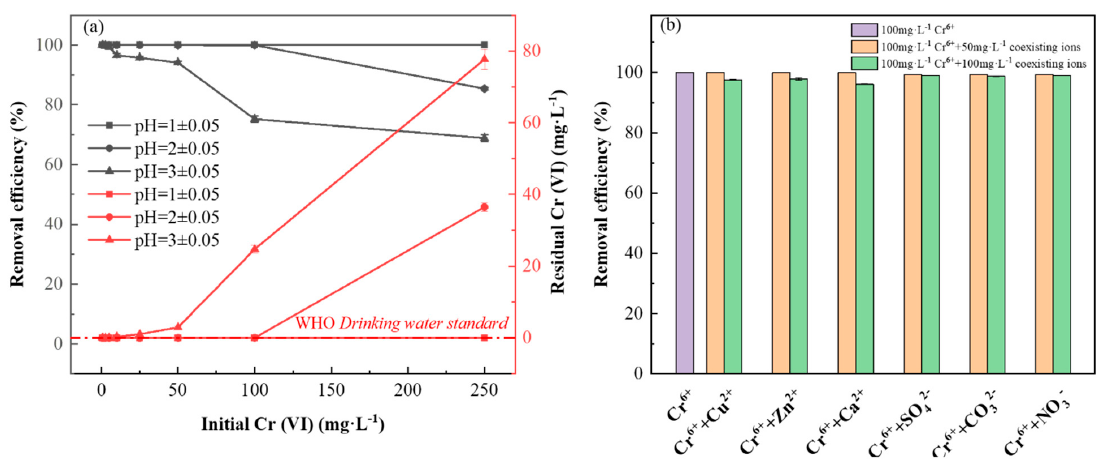
Figure 5. ( a ) Effect of different pH and Cr (VI) concentration on Cr (VI)removal rate. ( b ) Effect of Cu (II), Zn (II), Ca (II), SO 42 − , CO 32 − and NO 3 − at different concentrations on Cr (VI) removal rate of Cu (II), Zn (II), Ca (II), SO 4 2 − , CO 3 2 − and NO 3 − at different concentrations on Cr (VI) removal rate 100 mg ∙ L − 1. of 100 mg · L − 1